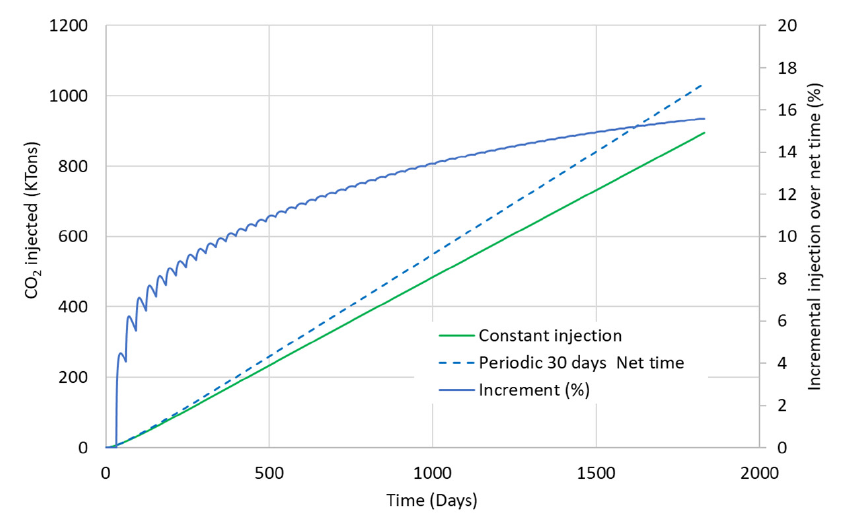
Figure 23. Results of periodic injection with a huge (unlimited) aquifer.